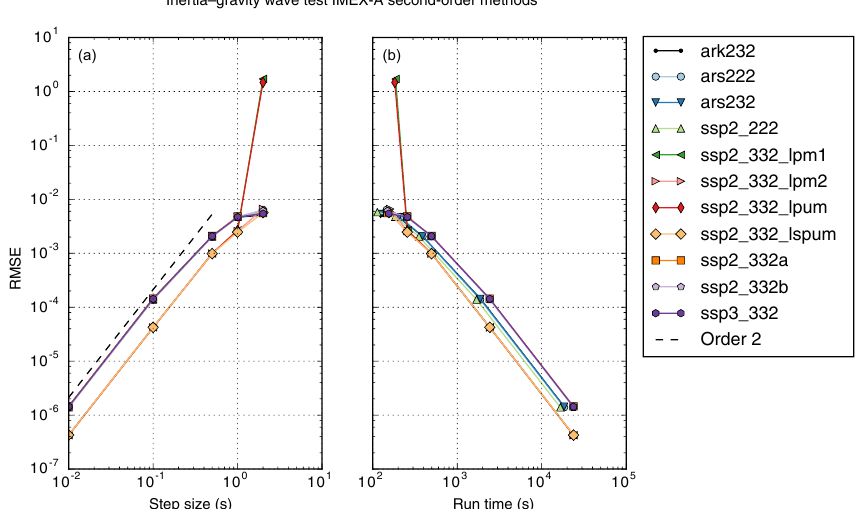
Figure 3. Accuracy (a) and efficiency (b) for the second-order methods using the Rosenbrock-like approach with the IMEX-A splitting. The ARK methods fall into two groups with similar accuracy. The dashed line represents second-order convergence. Results using multiple New- ton iterations to compute the stage solutions give nearly identical error values to the Rosenbrock-like results but increase the computational cost by at least 10%.